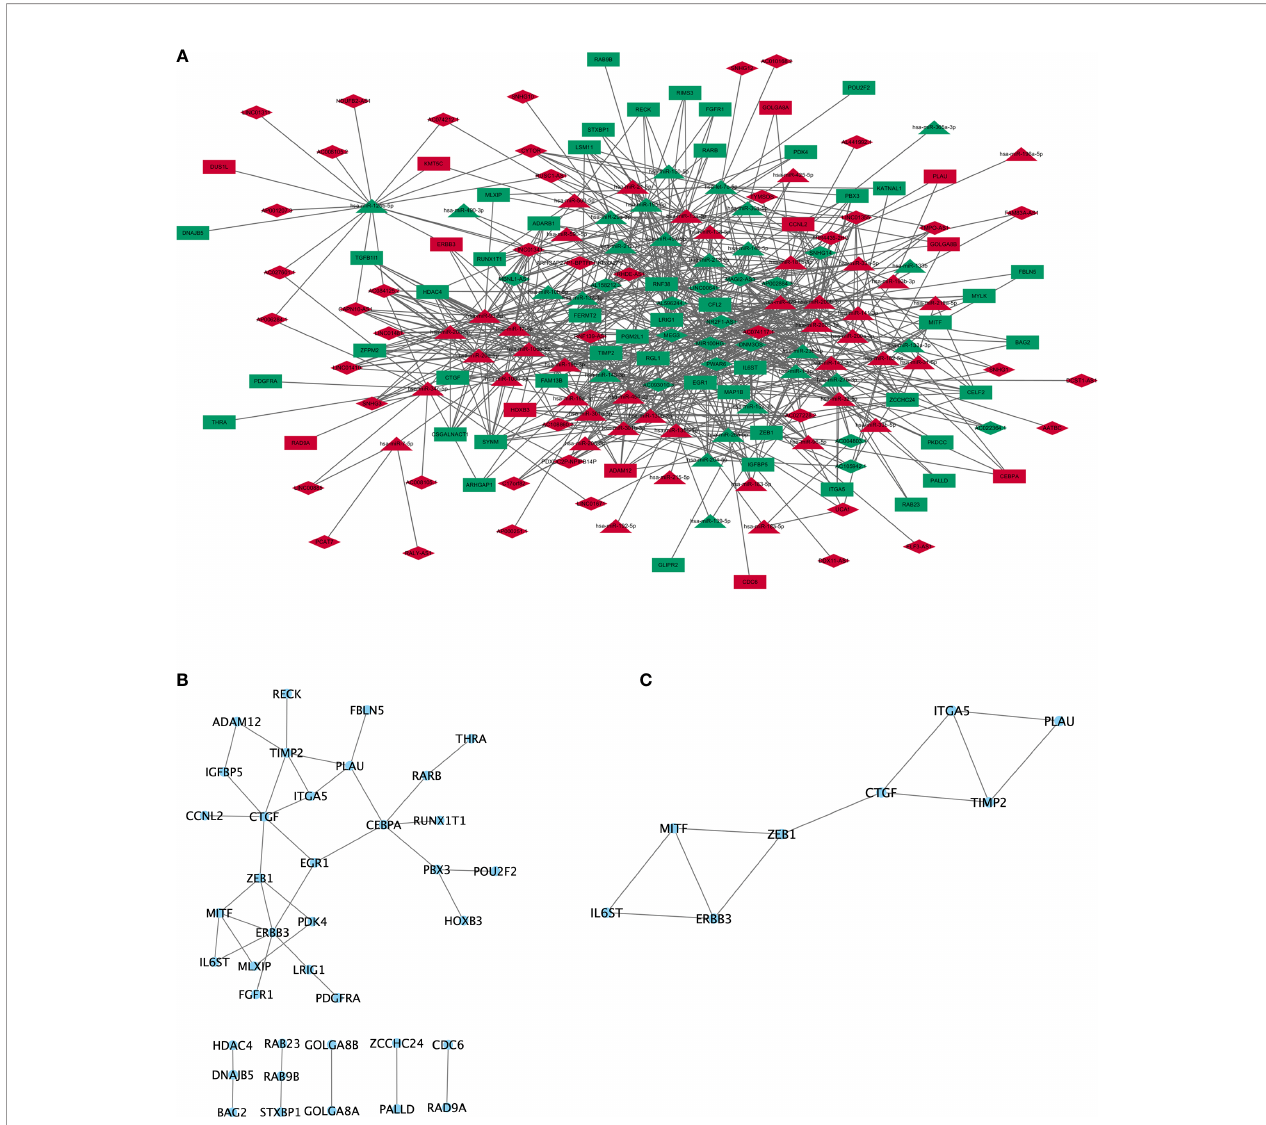
FIGURE 2 | ceRNA network and protein-protein interaction network. (A) lncRNA-miRNA-mRNA ceRNA network generated by Cytoscape (version 3.6.1, https:// cytoscape.org/). Red: upregulated RNAs. Green: downregulated RNAs. Triangle: miRNA. Diamond: lncRNA. Rectangle: mRNA. (B) PPI network of mRNA involved in the ceRNA network were generated by STRING (version 11.0, https://string-db.org/). (C) Subnetwork of PPI